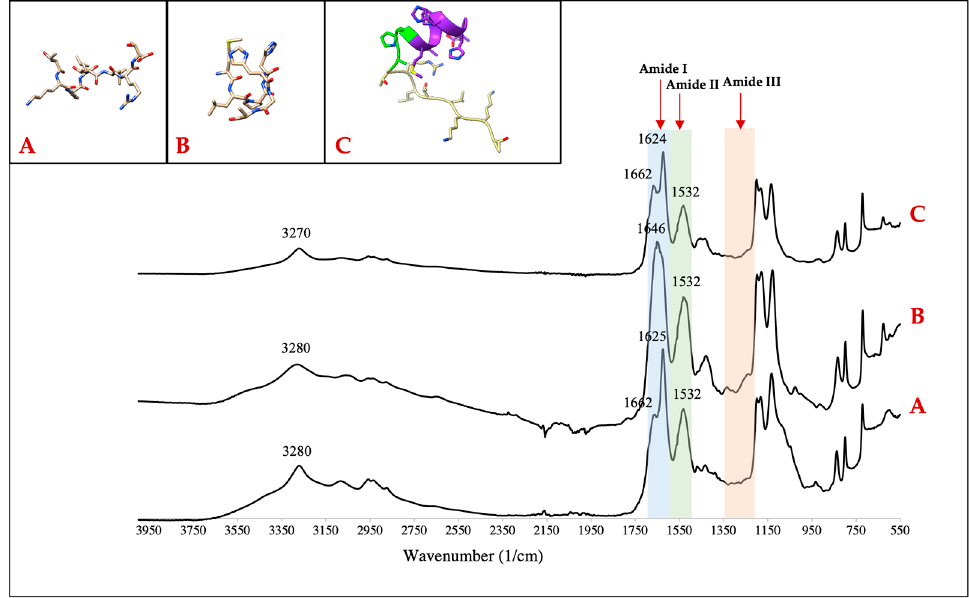
Figure 5. ( A ) Collagenase–collagen-binding peptide (CBP), sequence: TKKLTLRT. ( B ) Hydroxyapatite-binding peptide (HABP1), sequence: MLPHHGA. ( C ) Bifunctional peptide (CBP-HABP1), sequence: TKKLTLRT-APA-MLPHHGA. All peptide ribbon images shown are side views. All synthesized peptides are presented with corresponding FT-IR spectroscopy confirming molecular structure.